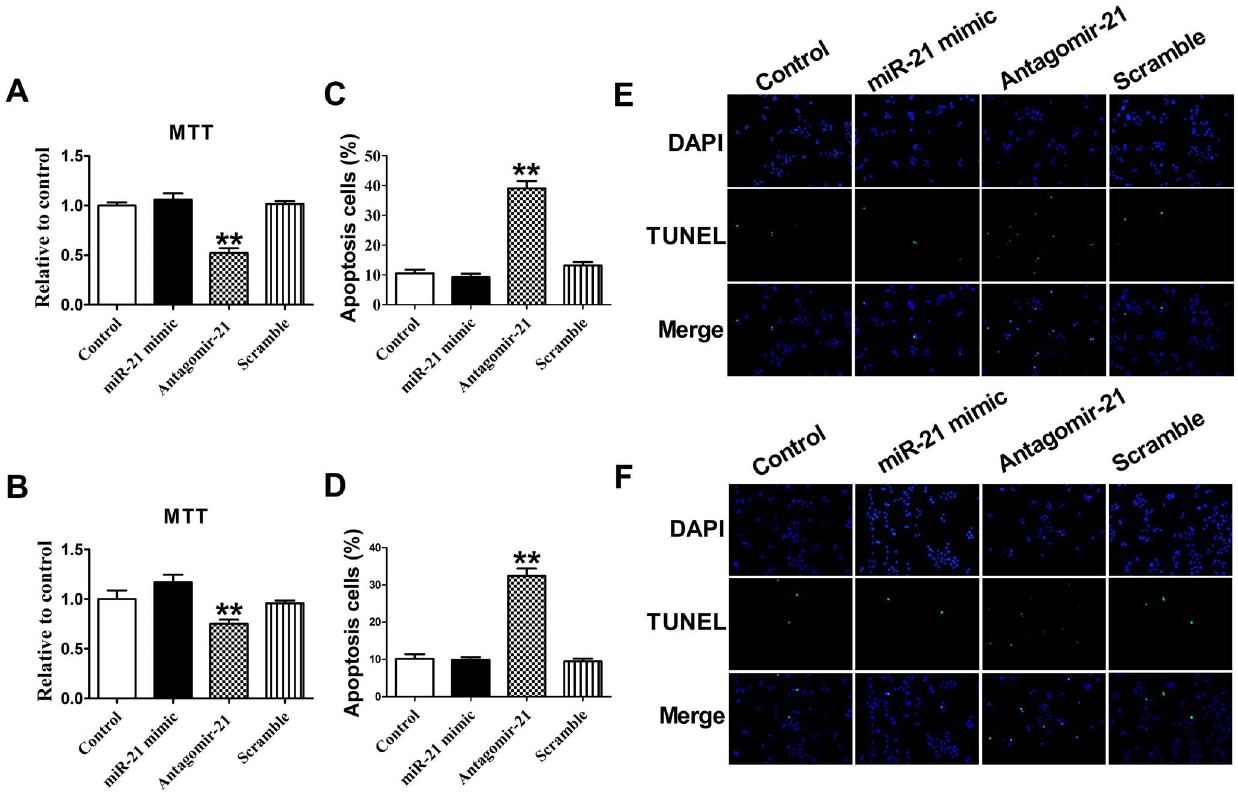
Figure 1. The effect of miR-21 antagomir on the cell proliferation and apoptosis. MTT assay of 4T1 cells (A) and HUVECs (B). Data are expressed as mean 6 SEM, n=3, ** P , 0.01 vs control. Quantification of apoptotic 4T1 cells (C) and HUVECs (D) were determined and shown in the diagram. The number of apoptotic cells was significantly increased in cells transfected with antagomir-21 than in control group. Data are expressed as mean 6 SEM, n=10, ** P , 0.01 vs control. (F). Apoptotic 4T1 cells (E) and HUVECs (F) were determined by TUNEL staining and visualized at 200 6 magnification. Green color is TUNEL staining representing apoptotic cell; blue color is the cell nucleus stained by DAPI.